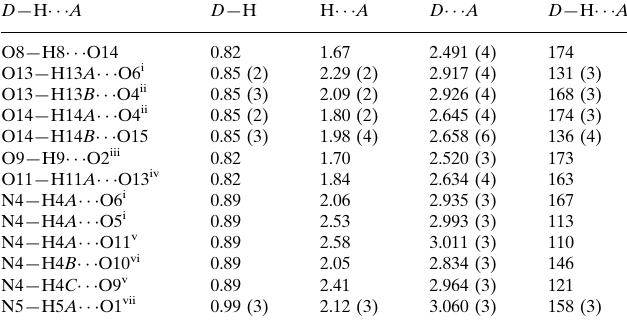
Hydrogen-bond geometry (A˚ , (cid:3)